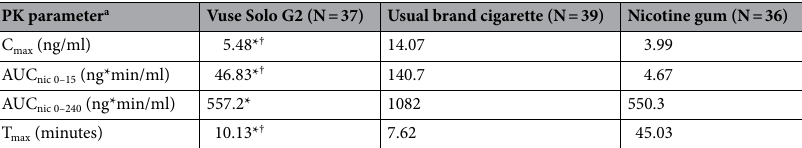
Table 2. Statistical comparisons of baseline-adjusted plasma nicotine uptake parameters between Vuse Solo and the high- and low-AL comparators. The high- and low-AL comparators were not compared to each other. C max maximum concentration, AUC nic 0–15 area under the curve from 0 to 15 min after the start of product use, AUC nic 0–240 area under the curve from 0 to 240 min after the start of product use, NA not assessed, T max time to maximum concentration. a Geometric least square means were used for the C max and AUC statistical comparisons; median values were used for T max statistical comparisons. Arithmetic means for C max were 7.3, 15.0, and 4.6 ng/ml, respectively, for Vuse Solo G2, UB, and nicotine gum. *Significantly different from usual brand cigarette; p < 0.05. † Significantly different from nicotine gum; p <